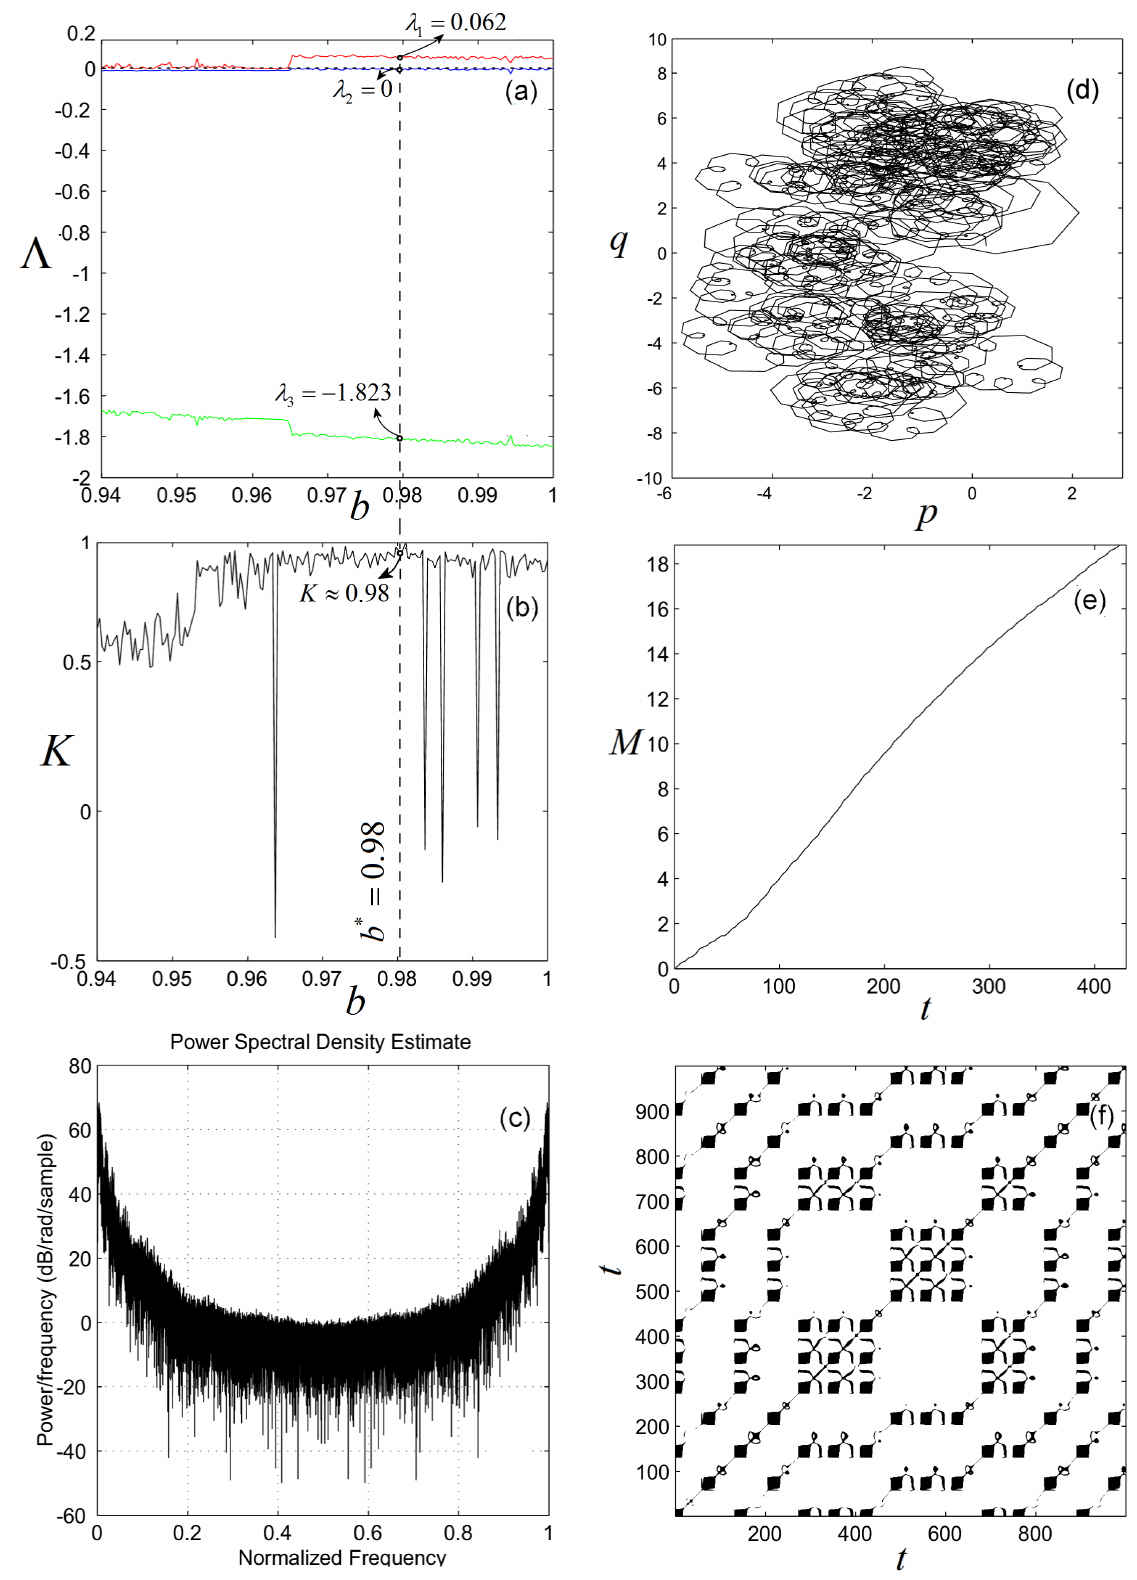
Figure 3. The SECA for b = 0.98. ( a ) The variation in the Lyapunov spectrum; ( b ) the variation in the median K ; ( c ) power spectral density; ( d ) the graph of p and q ; ( e ) the graph of the mean-square displacement M ; ( f ) the recurrence